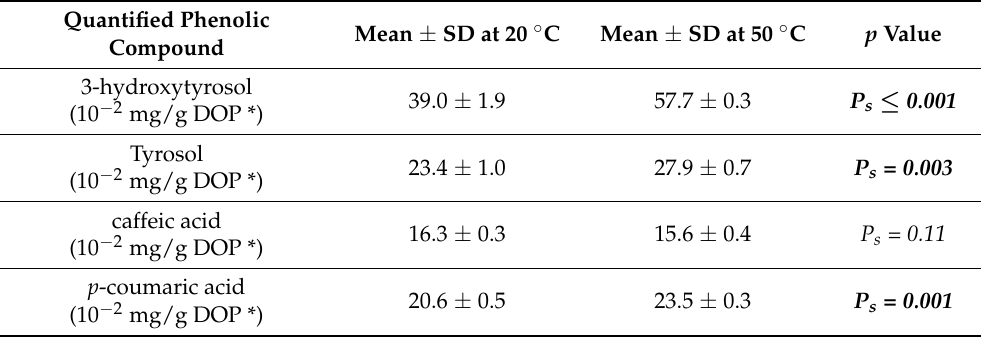
Table 2. A comparative table of the mean values of quantified phenolic compounds at 20 min maceration at 20 °C and 50 °C.